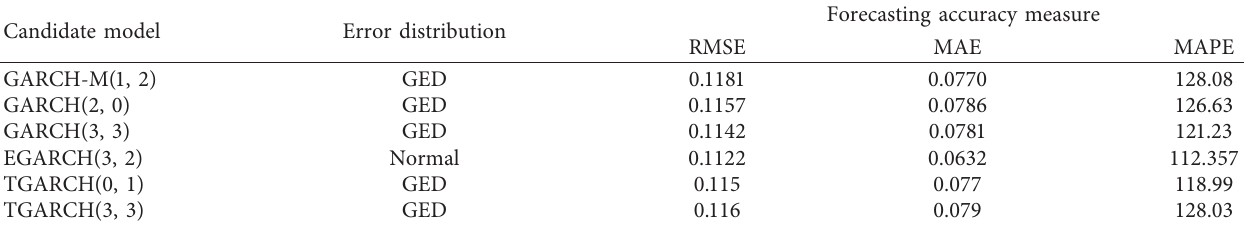
Table 6: Comparison of candidate models for the price volatility of silver using the forecasting accuracy